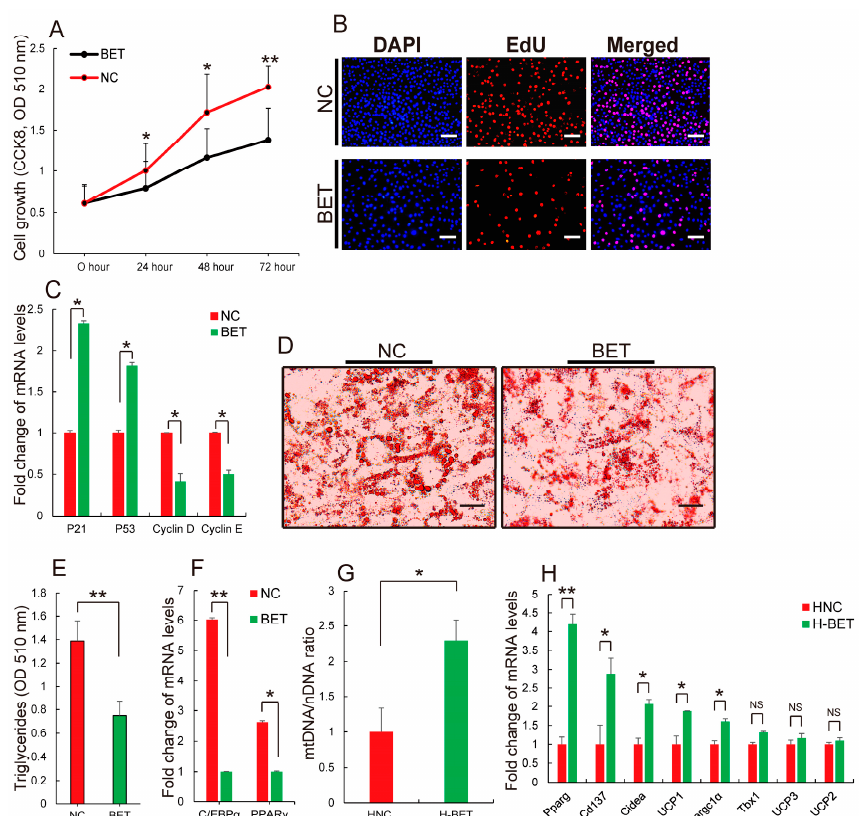
Figure 4. Betaine supplementation prevents the formation of new white adipose tissue (WAT), and guides original WAT burning in HFD-fed mice. Once 3T3-L1 cells were treated with 20 mM betaine, ( A ) cell proliferation was evaluated at 0 h, 24 h, 48 h and 72 h of proliferation by performing CCK8; ( B ) EdU proliferation assay was performed at 24 h to label proliferating cells; ( C ) The mRNA levels of genes related to cell proliferation were quantified. Additionally, 3T3-L1 cells were induced differentiation for 8 days; ( D ) cells were stained with oil red O; ( E ) triglycerides content was analyzed; ( F ) the mRNA levels of C/EBP α and PPAR γ by qRT-PCR was measured and Scale bar, 10 µ m. Meanwhile, after HFD-fed mice were fed with 1% betaine in water (H-BET) or without 1% betaine in water (HNC); ( G ) adipose tissue mitochondrial content was determined by the ratio of mtDNA/nDNA ( n = 6); ( H ) qRT–PCR analysis of genes related to brown adipocyte ( n = 6). All results are presented as means ± standard error (SE). Scale bar, 10 µ m. * p < 0.05; ** p < 0.01; NS, no significance. BET,